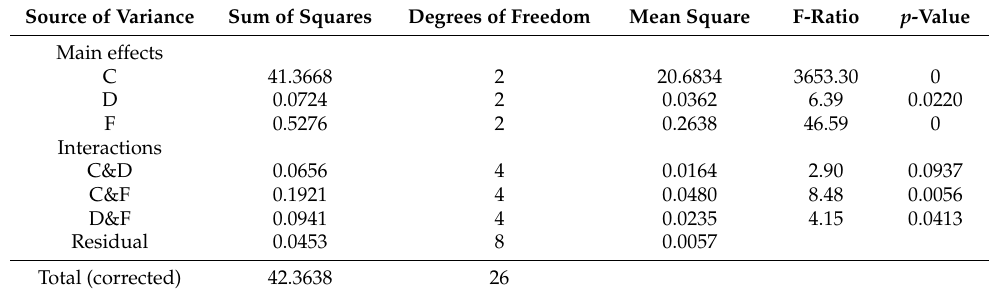
Table 5. ANOVA test results on